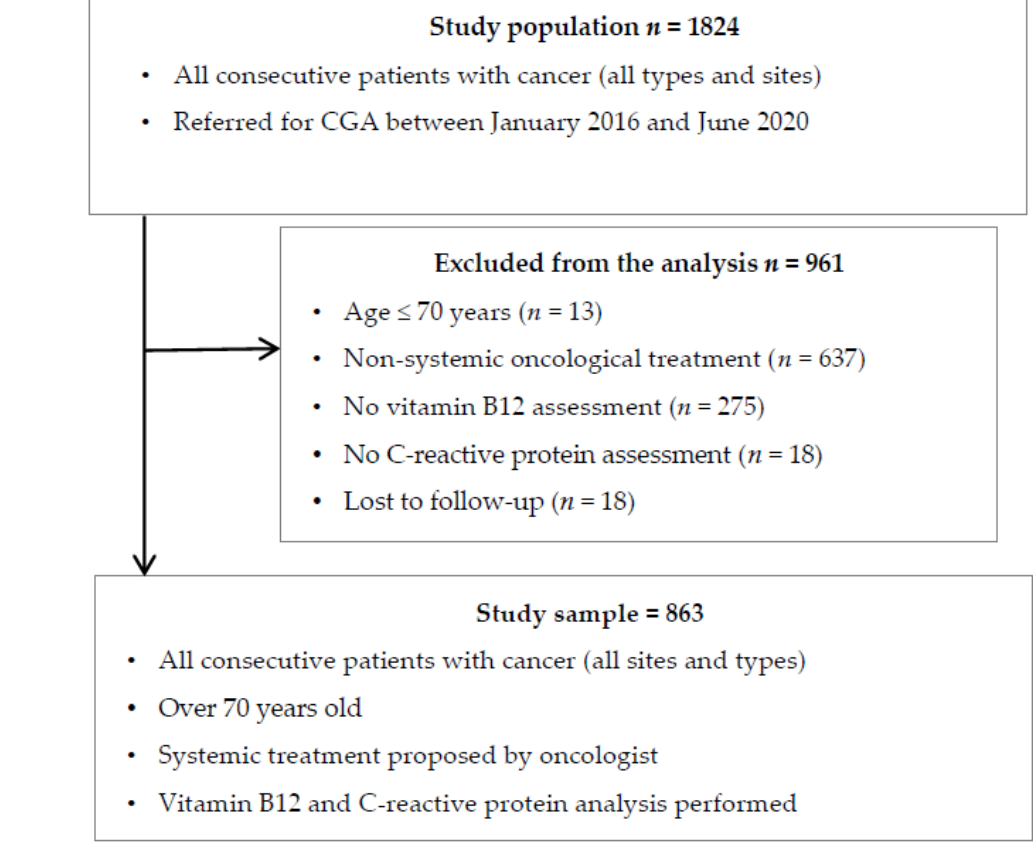
Table 1. Descriptive and comparative analysis.